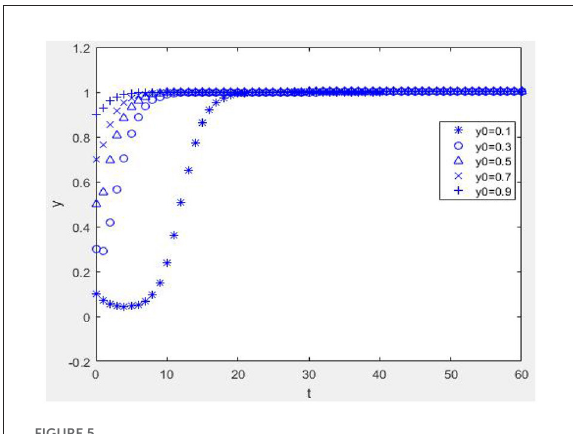
FIGURE5 Dynamic evolution diagram under Case 3( R 1 = 9 or α = 9).